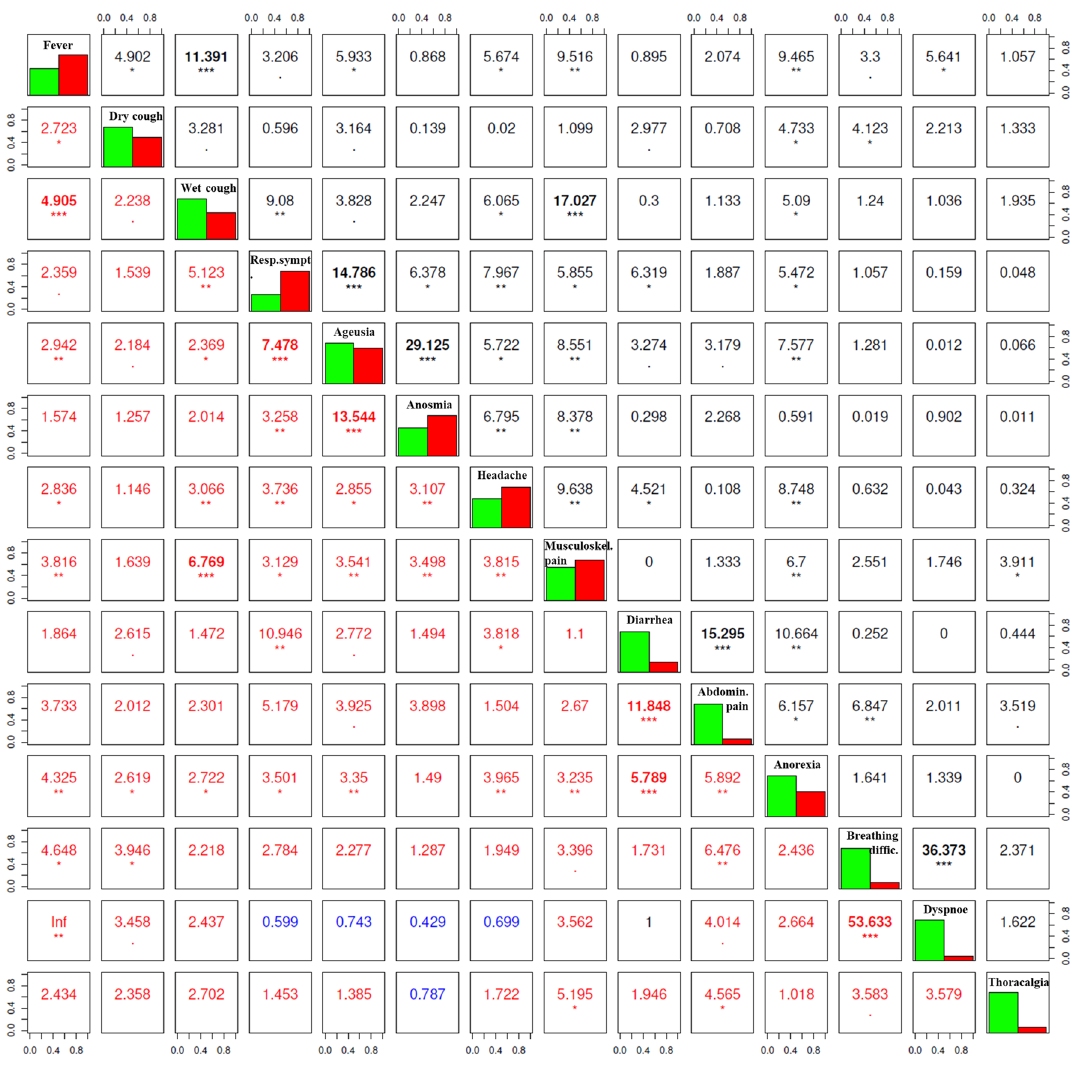
Figure 4. The correlation between COVID-19-symptoms’ co-occurrence in outpatients evaluated by using the Pearson’s Chi-squared tests (upper right) and Fisher’s odds ratio exact tests (lower left). Figure represents the relation between symptoms’ co-occurrence. The diagonal from the upper left corner to the lower right corner contains frequency histograms of each variable (green—symptom absent; red—symptom present). The Pearson’s Chi-squared tests (on the right top of the diagonal) measure the strength of a linear association between categorical variables presented by the Pearson correlation coefficient. The Fisher’s odds ratio exact tests (on the bottom left of the diagonal; red and blue numbers indicate positive and negative associations, respectively) represent the ordinal dependence between two measured quantities. Each significance level is depicted by stars: *p < 0.05; **p < 0.01; ***p < 0.001. Only symptoms co-occurring in more than three patients were included. COVID‑19 Coronavirus Disease